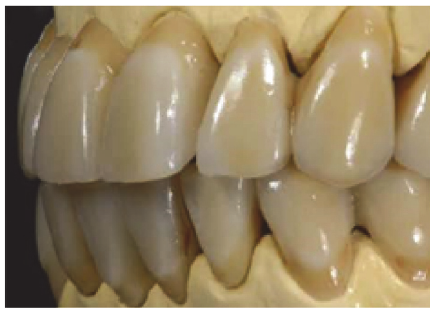
Figure 23: Lateral left view.